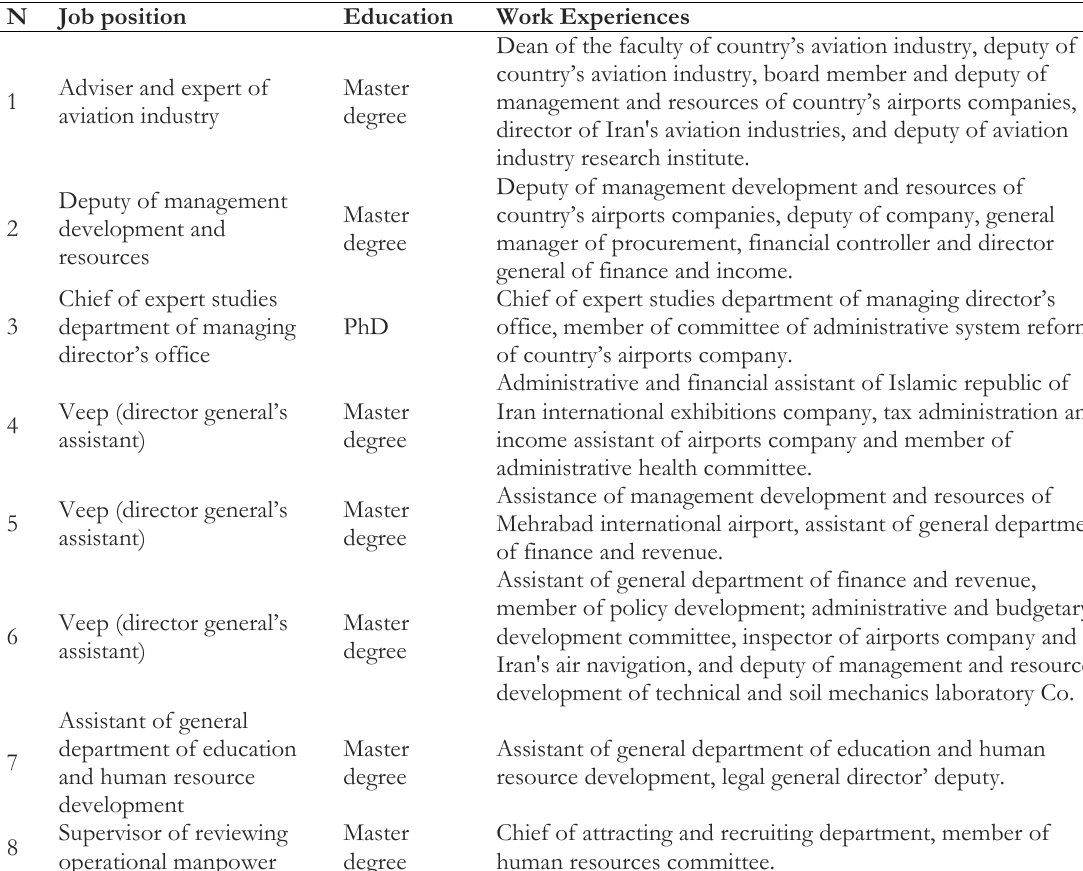
Table 3. Expert ’s